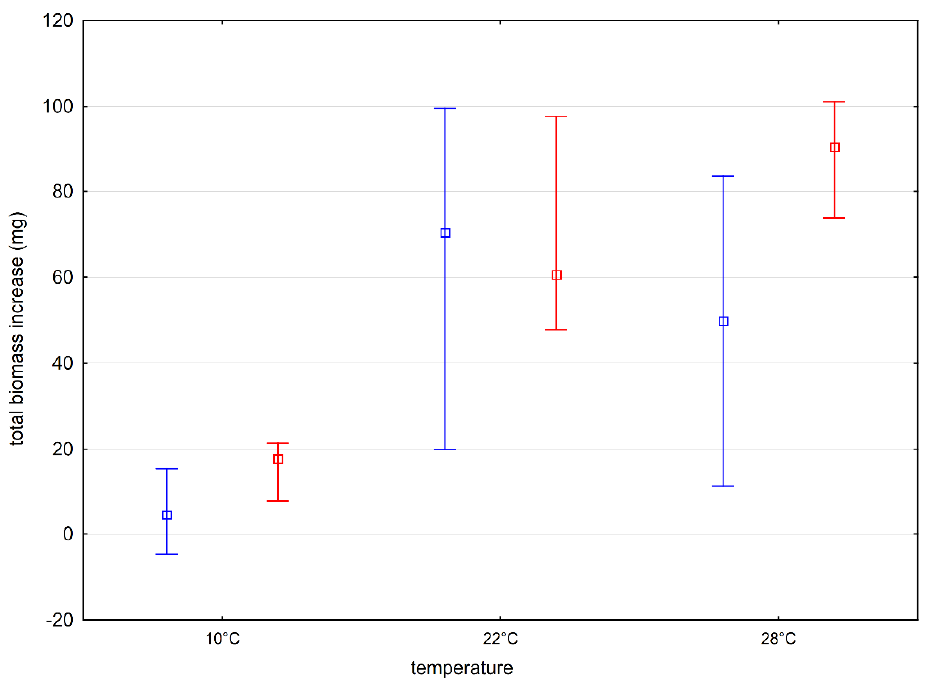
Figure 4. Increase in biomass (mg F.W.) of plants developing from turions under different thermal conditions. Plants from the natural site in Lake Długie are marked in blue, while plants from Lake Łukie are marked in red. Whiskers indicate the range of values, and squares indicate the median.